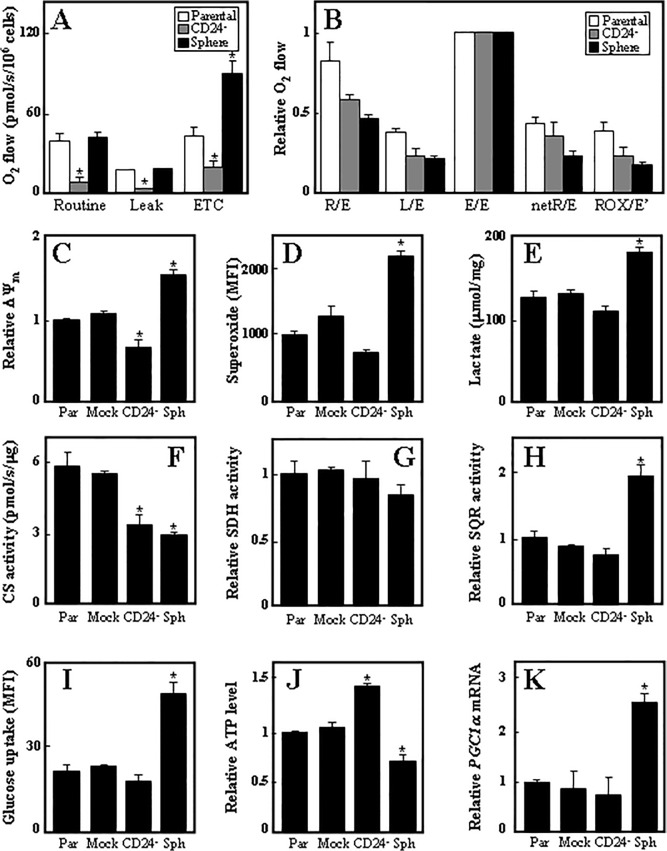
Effect of CD24 knock-down on mitochondrial function.Parental and CD24- adherent and sphere Ist-Mes-2, non-permeabilised cells were evaluated for routine respiration using the Oxygraph instrument (A). Panel B shows respiration related to the maximum respiratory capacity of the cells (ETC). The symbols in panel A stand for: R, routine, L, leak, E, ETC, netR, R-L, ROX, residual respiration. Parental, mock-transfected, CD24- adherent and sphere Ist-Mes-2 cells were evaluated for ΔΨm using TMRM (C), superoxide generation using MitoSOX (D), lactate production using a commercial kit (E), citrate synthase (CS) activity (F), relative SDH (G) and SQR activity (H), glucose uptake (I) and ATP level (J). Panel K documents the level of PCG1αmRNA in parental, mock-transfected and CD24- adherent and sphere Ist-Mes-2 cells. Data shown are mean values ±S.D., and are derived from three individual experiments. The symbol ‘*’ denotes statistically significant differences with p<0.05.